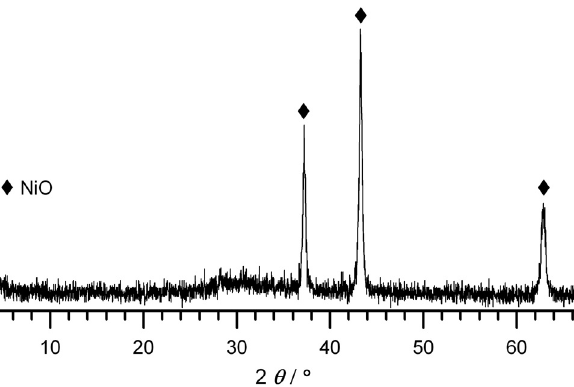
Figure 8. XRD pattern of the product after thermal treatment of [ Ni(dtsq) ] under a nitrogen (BuPh P) 3 2 2